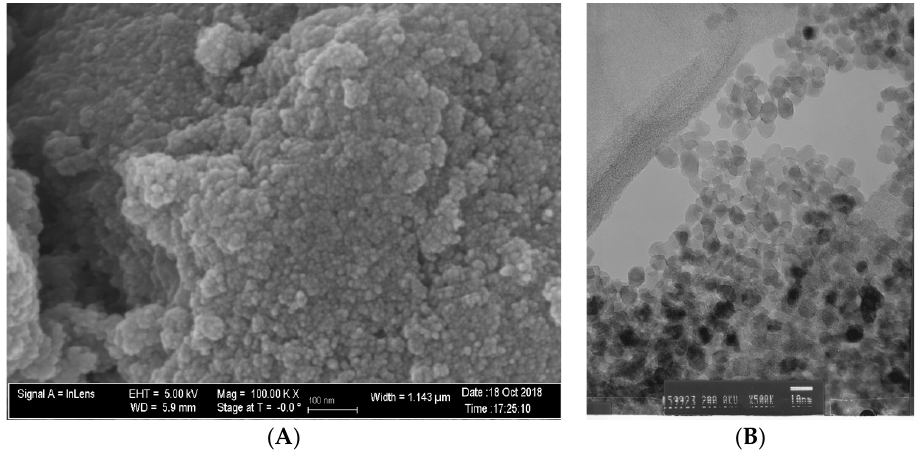
Figure 1. ( A ) SEM (magnification 100 k  ) and ( B ) TEM (magnification 500  ) micrographs of non ‐ immobilized N_TiO 2. immobilized N_TiO 2